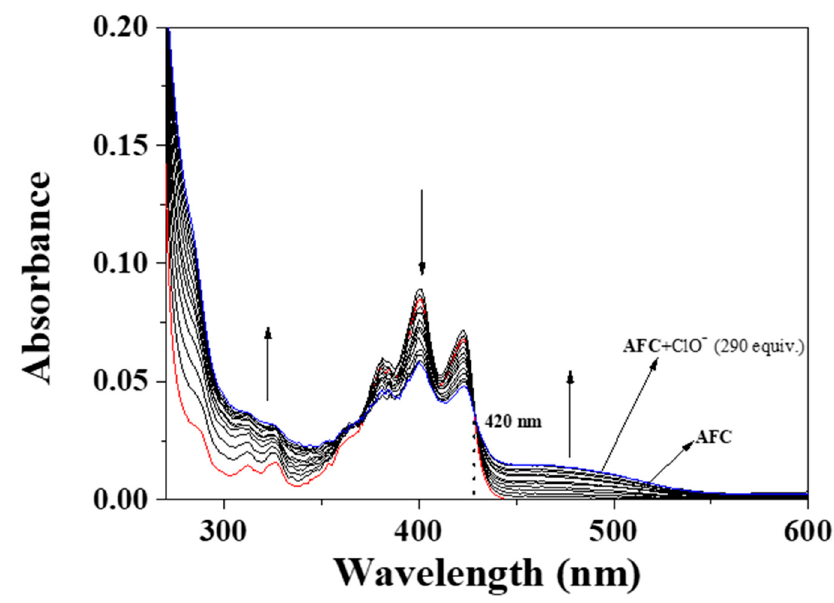
Figure 3. UV–VIS change of probe AFC (1 × 10 − 5 M) with different amounts of ClO − .